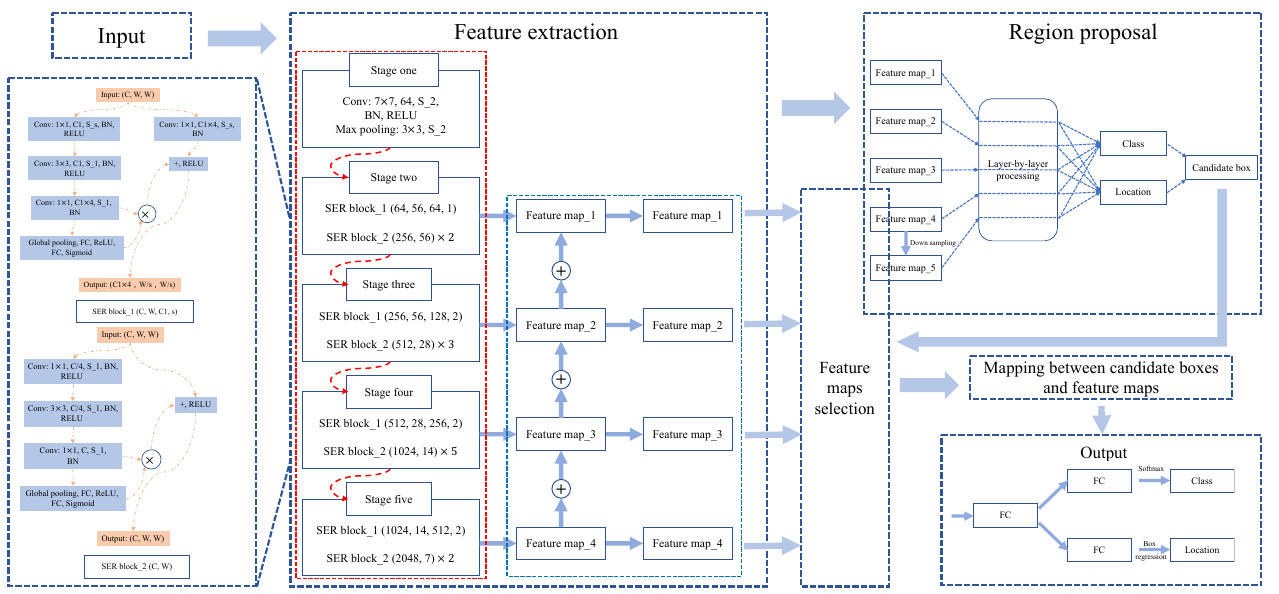
Figure 2. The structure of SEM-RCNN. Figure 2: (a) Input: The dataset contains images of 21 types of EMs and their corre- sponding labeled images. There are 840 images in total, and each type has 40 original images (Sections 4.1 and 4.2.1 for details). (b) Feature extraction: A combination network based on SENet and feature pyramid network (FPN) is proposed for fuller and deeper feature extraction (Section 3.1 for details). (c) Region proposal: A region proposal network (RPN) was applied to obtain multi-candidate boxes of the object (Section 3.2 for details). (d) Mapping between candidate boxes and feature maps: The method based on the region of interesting align (ROI align) is applied for accurate mapping between candidate boxes and the feature map, as well as the mapping between the feature map and the fixed size feature map (Section 3.3 for details). (e) Output: A multi-branched structure is applied for feature maps regression, and the combined approach of the fully connected layer, bounding box regression, and Softmax is applied for object detection (Section 3.4 for